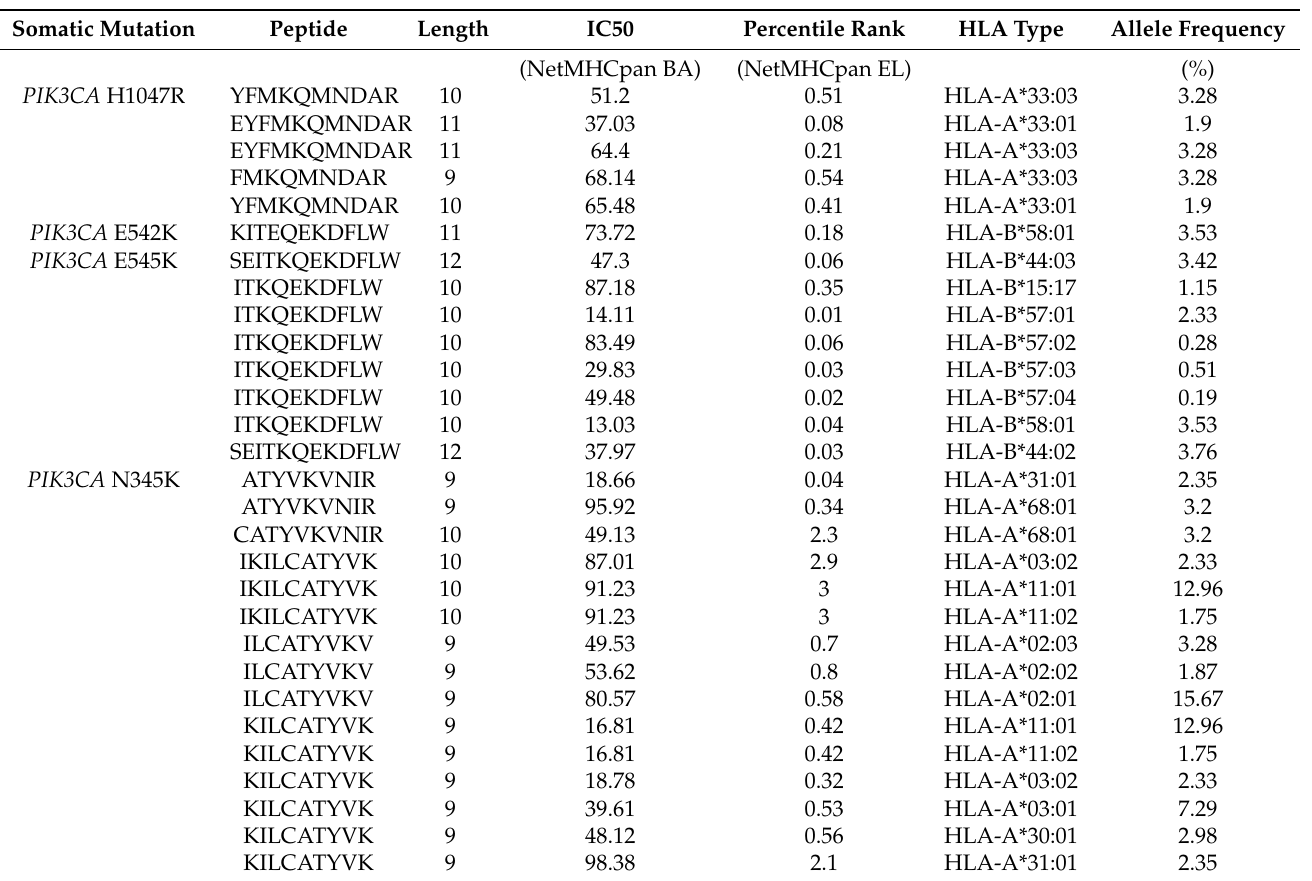
Table 3. Binding affinity prediction results between peptides of recurrent somatic mutations and MHC class I. The table showed only peptide-MHC class I pairs with a predicted binding affinity of less than 100